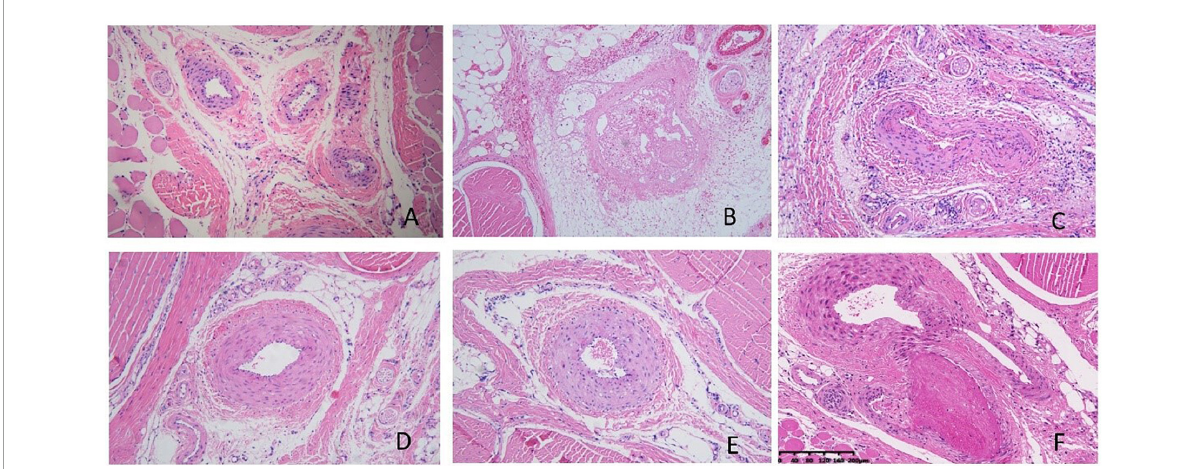
FIGURE7 Pathological images of tail tissue under different treatments. (A) Normal control group, no defects in the intima of the vessel, the structure was normal and the vessel wall showed no abnormalities. (B) Model group, inflammation occurred with significant inflammatory cell infiltration and edema around the vessels, the vessels were blocked with mixed thrombi. Vessel walls were necrotic and showed homogeneous red staining. (C) Aspirin group; (D) water-soluble tomato concentrate (WSTC) 150 mg · kg − 1 group, (E) WSTC 75 mg · kg − 1 group, and (F) WSTC 25 mg · kg − 1 group. The scale bar is 200 µ